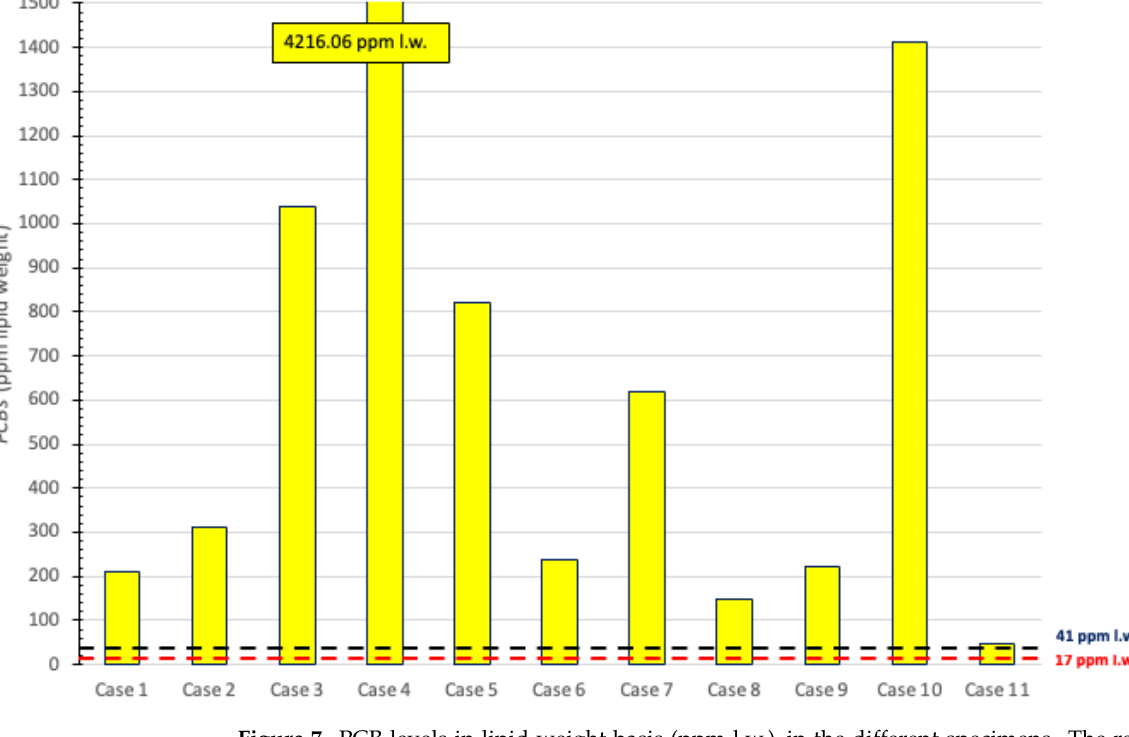
Figure 7. PCB levels in lipid weight basis (ppm l.w.) in the different specimens. The red dotted line represents the PCB threshold (17 ppm l.w.) indicated to produce deleterious effects in marine mammals. The black dotted line represents the highest reported PCB toxicity threshold (41 ppm l.w.) for marine mammals.